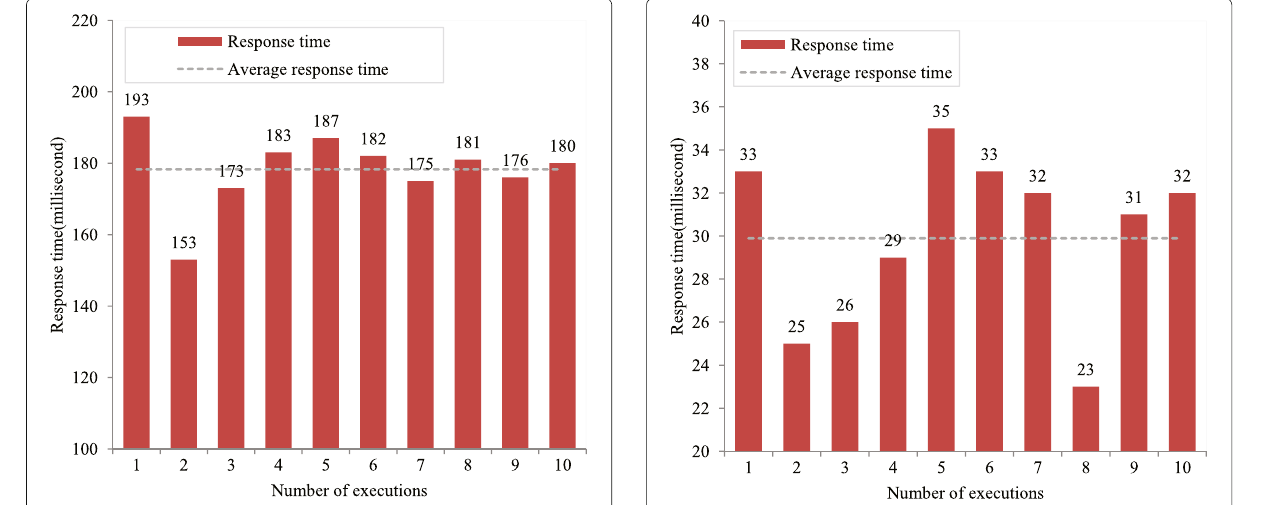
grid ranges, which could reduce the amount of data and transmission time.